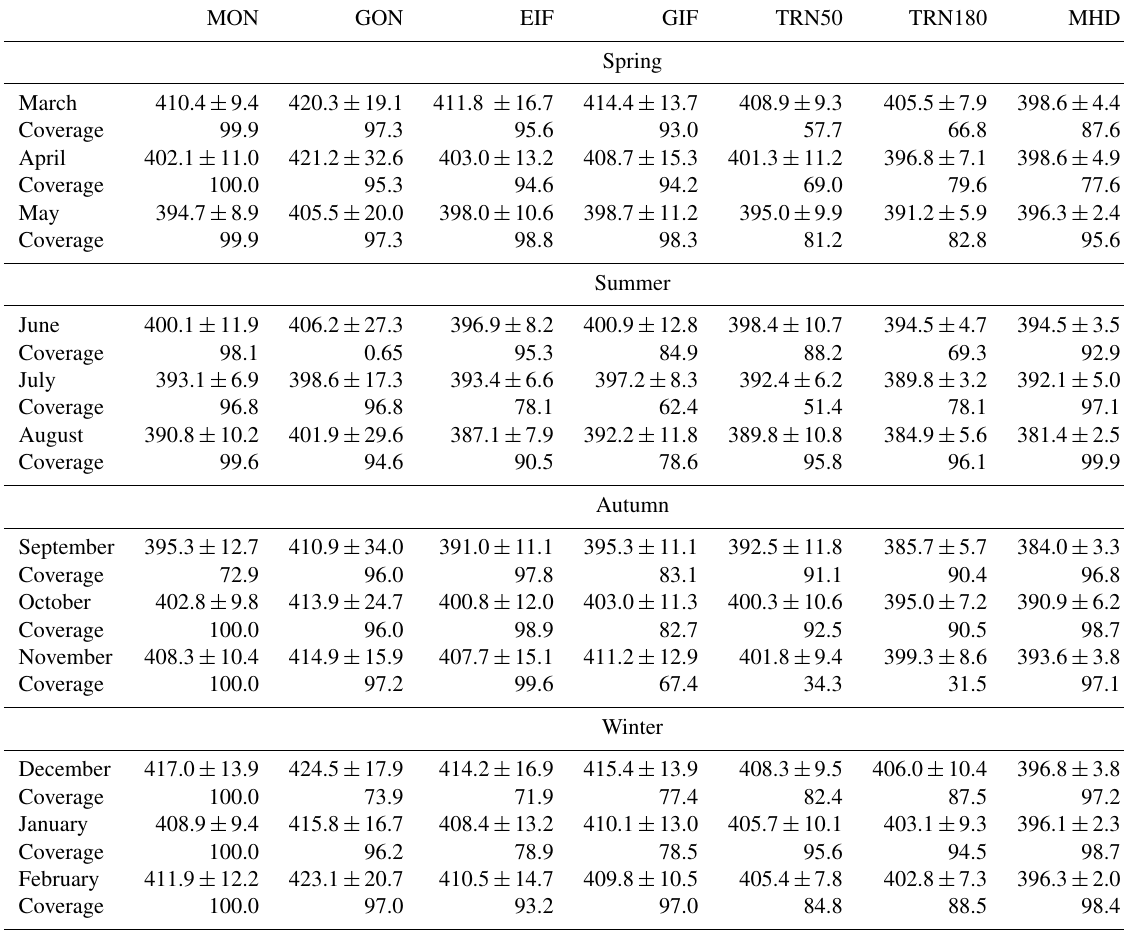
Table 3. Monthly means and standard deviation ( ± 1 σ) of the CO 2 concentration (in ppm) measured at each site and data coverage of each month (in